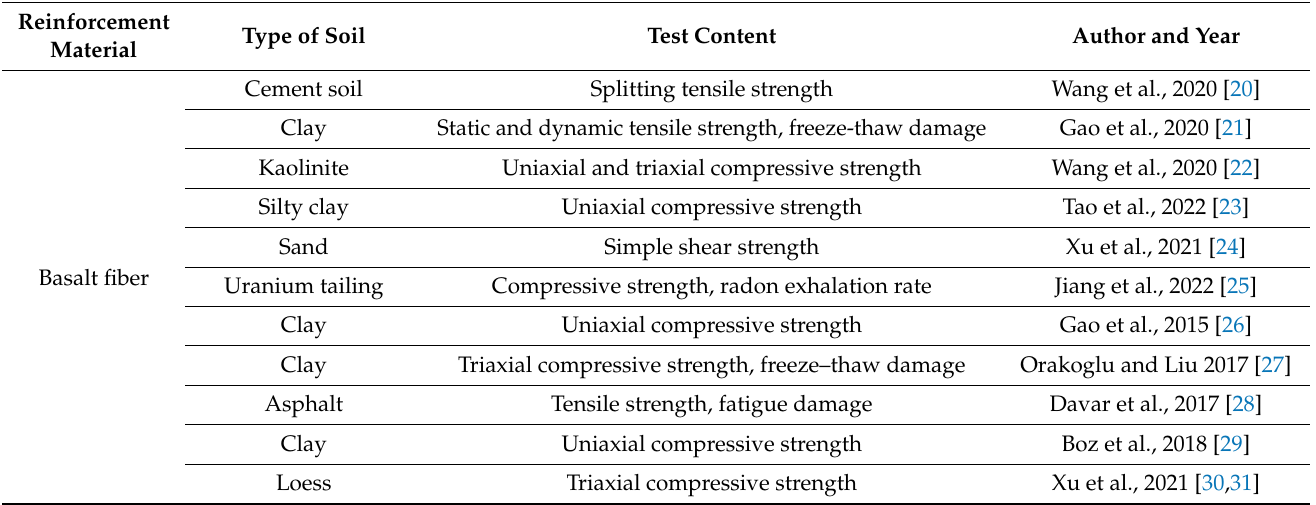
Table 1. Research on the application of basalt fibers for soil